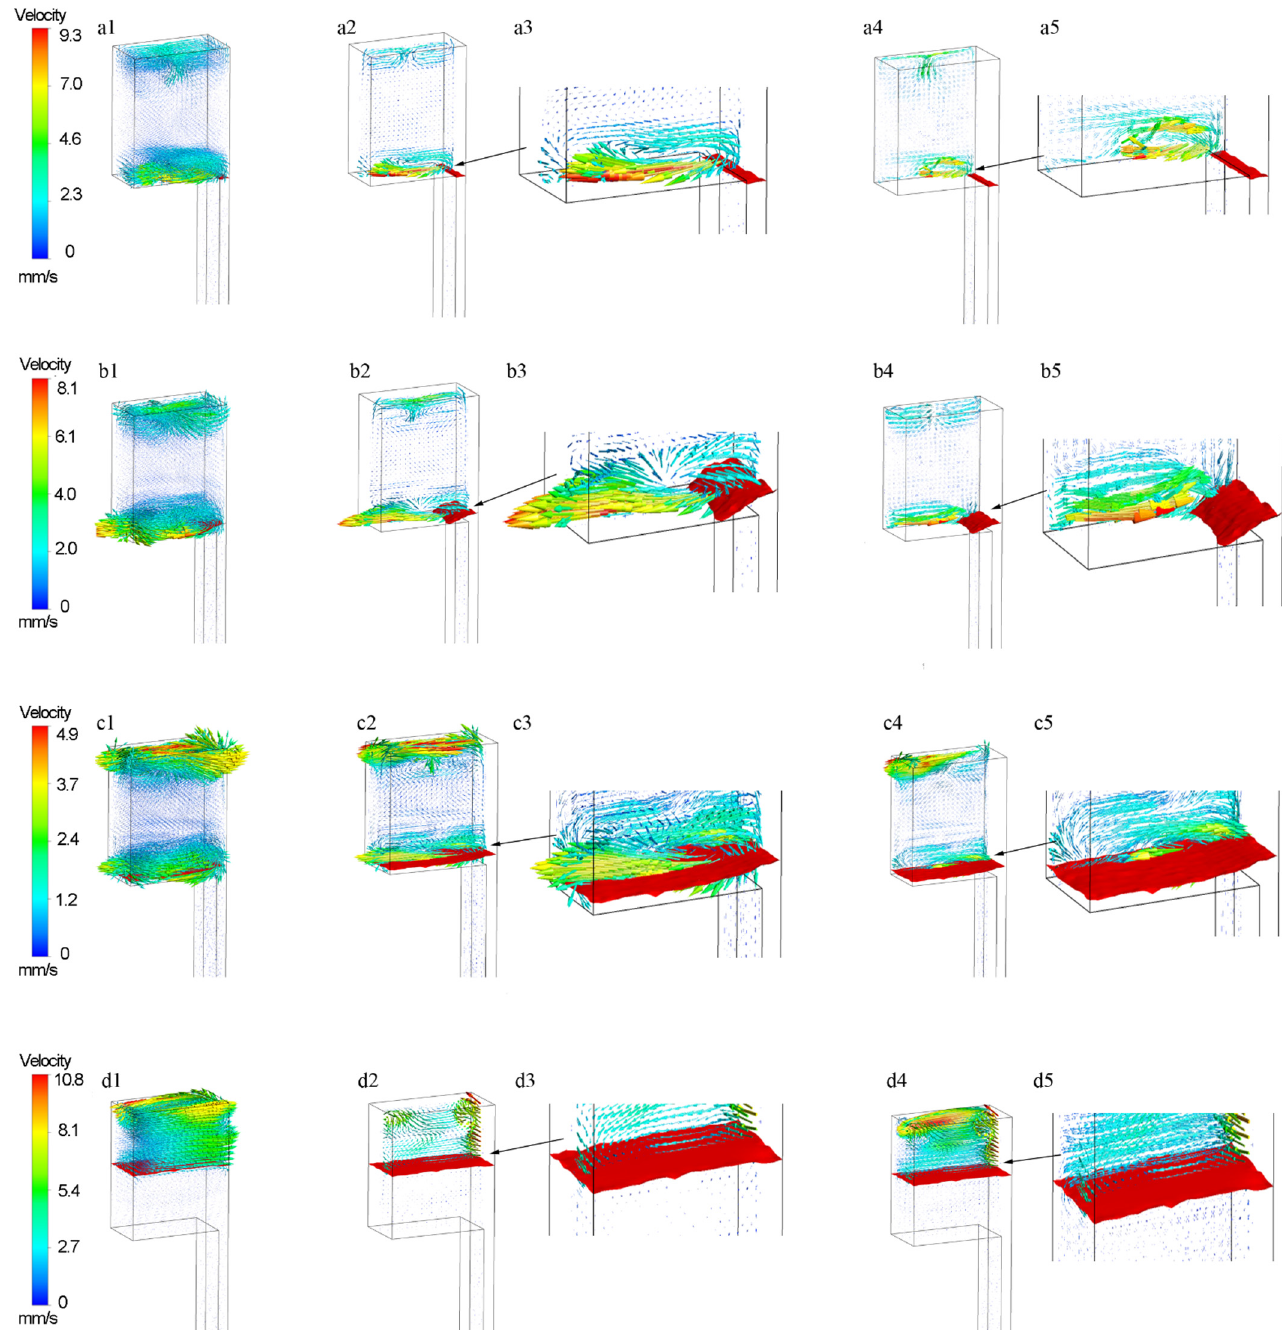
Figure 4. The velocity vector distributions at different times. ( a1 – d1 ) show 3D velocity vectors at 824 s; 900 s; 1040 s; 1280 s, respectively; ( a2 – d2 ) show 2D velocity vectors in the mid-vertical plane of ( a1 – d1 ); ( a3 – d3 ) show 2D velocity vectors at front of solidification in ( a2 – d2 ); ( a4 – d4 ) show 2D velocity vectors in the surface and 2D velocity vectors at front of solidification in ( a4 – d4 ) as shown in ( a5 – d5 ), respectively. Solidification gradually proceeds to a large cross section at 900 s. The right side of the solidification interface buckles upward. In Figure 4(b3), the flow form at the solidification interface front in the central longitudinal section does not change significantly. However, in the surface longitudinal cross-section, the vortex at the solidification interface front